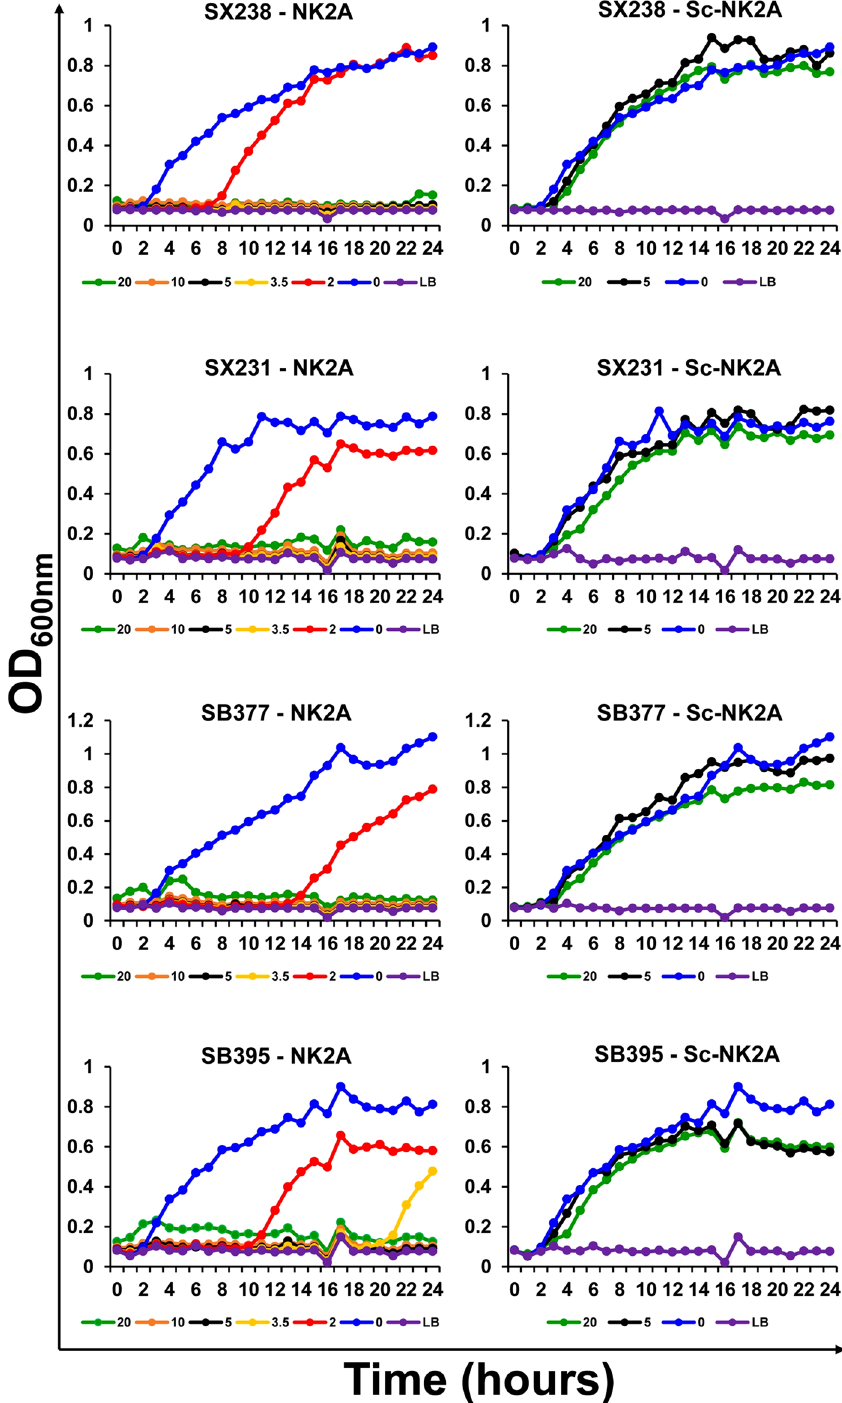
Figure 3. Antimicrobial activity of NK2A and Sc-NK2A against Salmonella isolates. Three MDR Salmonella outbreak isolates (SX238, SX231 and SB395) and one non-MDR Salmonella isolate (SB377) (10 6 CFU/mL) were incubated with different concentrations of NK2A, Sc-NK2A or Luria–Bertani broth (LB) and optical densities (OD 600nm ) were recorded using an automated growth curve reader over a 24 h period. One representative graph (for each peptide and each isolate) out of at least three independent experiments is